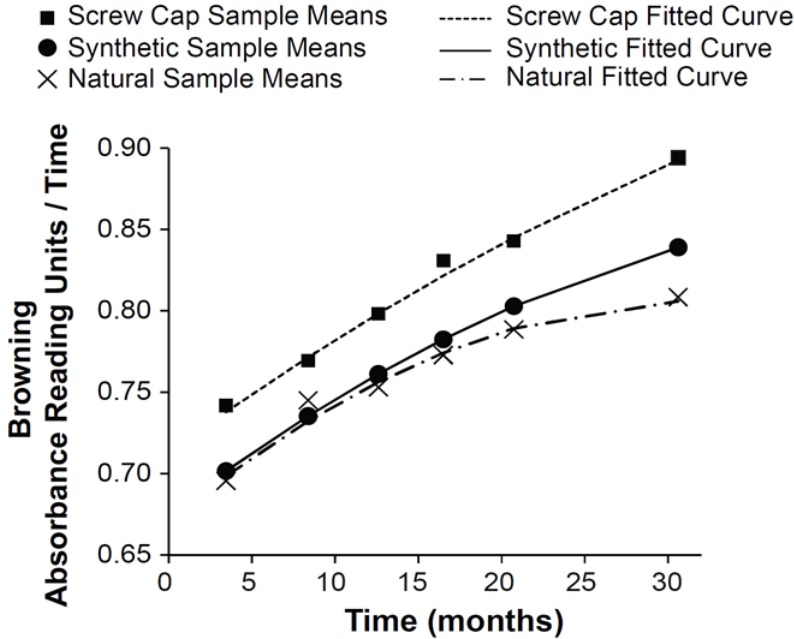
Figure 1. Fitted browning trajectories of the typical bottle by closure type . Table 1. Indices of fit for growth models fit to browning level .